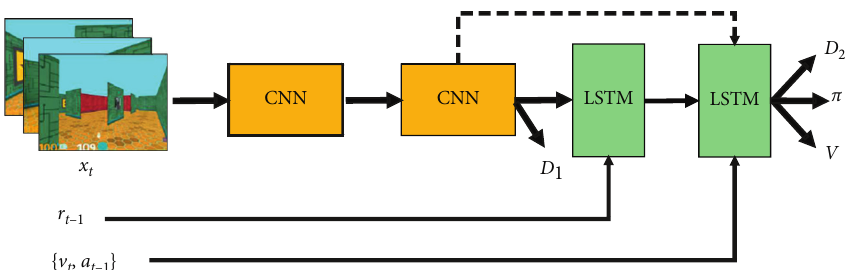
Figure 1: a3cNav architecture. In the architecture, image x t is the input of a3cNav , and following the full connection layer is a two-layer CNN which outputs depth D 1 as well as a two-layer stacked LSTM which outputs depth D 2 , policy π , and value V . In addition, auxiliary task used in this architecture in which the first LSTM only receives the reward and the velocity and previously selected action are fed into the second